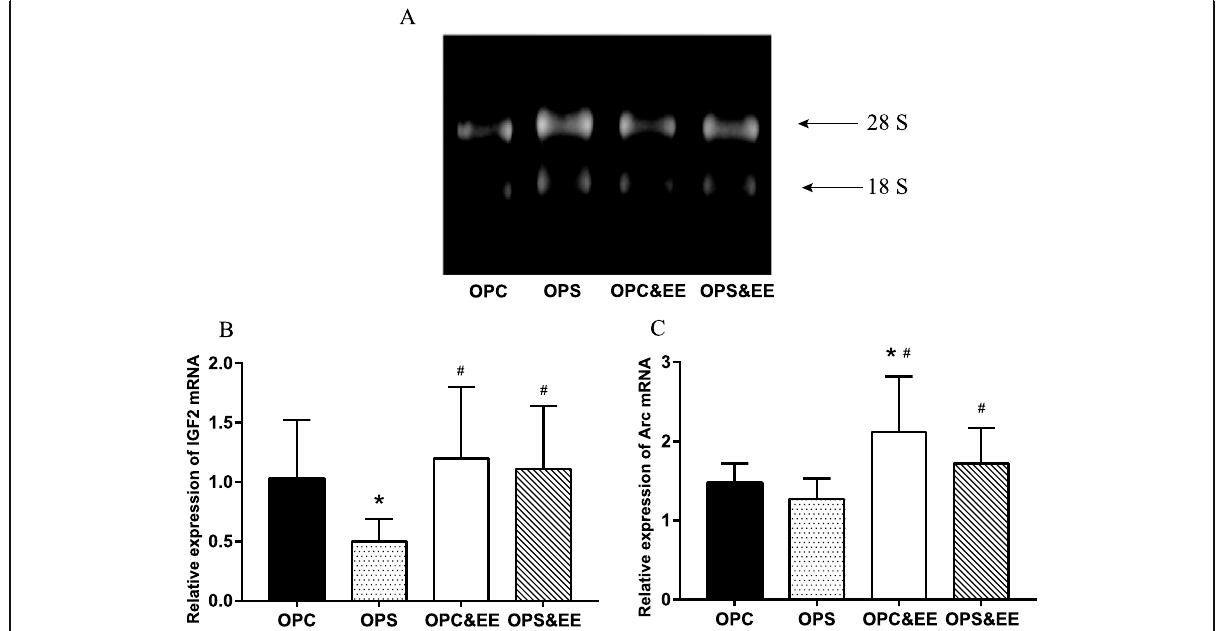
Fig. 7 The comparison among OPC, OPS, OPC&EE, and OPS&EE in the IGF-2 mRNA and Arc mRNA expression in the offspring ’ hippocampus. The IGF-2 mRNA and Arc mRNA expression of PS offspring were lower than it of PC offspring; however, they were boosted by EE. Data were respectively analyzed using one-way ANOVA, followed by LSD-t test to make comparison at the two different groups. Number of animals in each offspring group = 16 (50% male, 50% female). ( a The determination of RNA purity. b The IGF-2 mRNA relative expression of offspring. c The Arc mRNA relative expression of offspring. * P < 0.05 vs. OPC. # P < 0.05 vs.